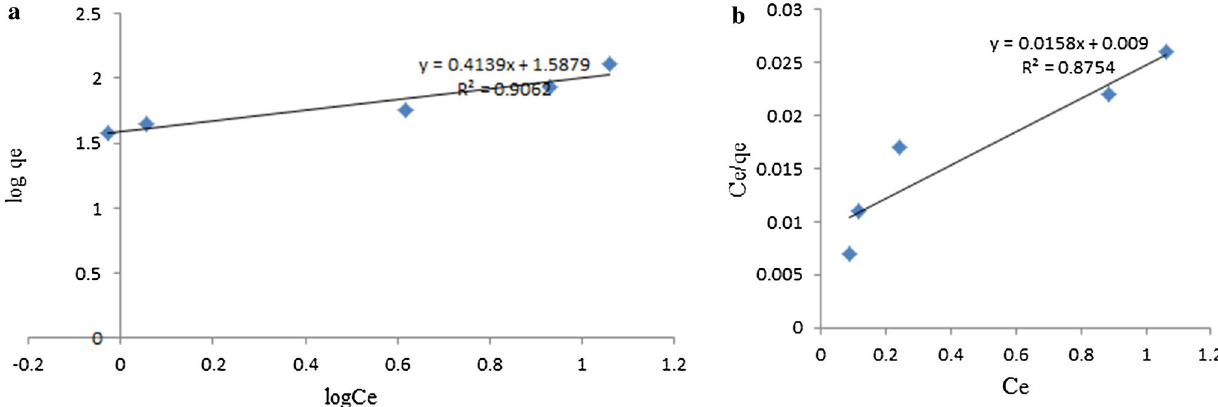
Fig. 5 The plots of Freundlich isotherm ( a ) and Langmuir isotherm ( b